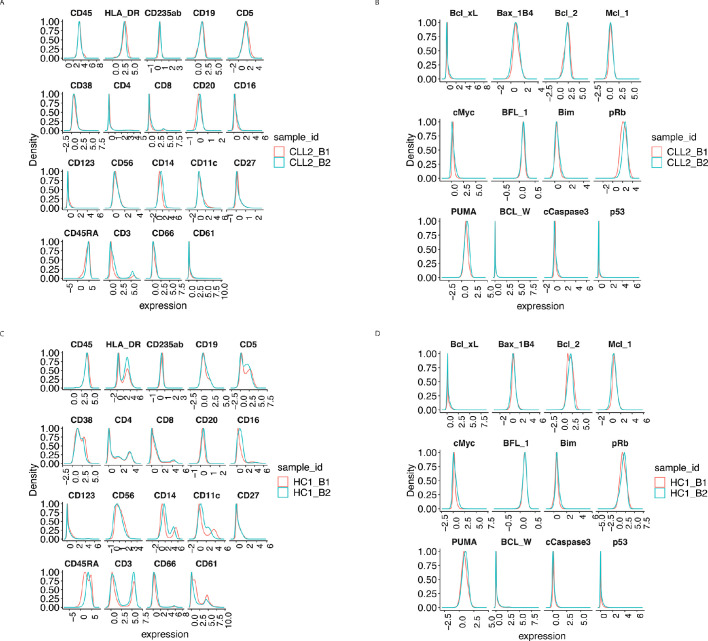
Protein distributions after CytofRUV normalisation with k = 5 for the samples CLL2 and HC1 across batch 1 and batch 2.(A) Lineage protein expression distributions for the CLL2 sample across batches, after CytofRUV normalisation. (B) Same as (A) with functional proteins. (C) Lineage protein expression distributions for the sample HC1 across batches, after CytofRUV normalisation. (D) Same as (C) with functional proteins.